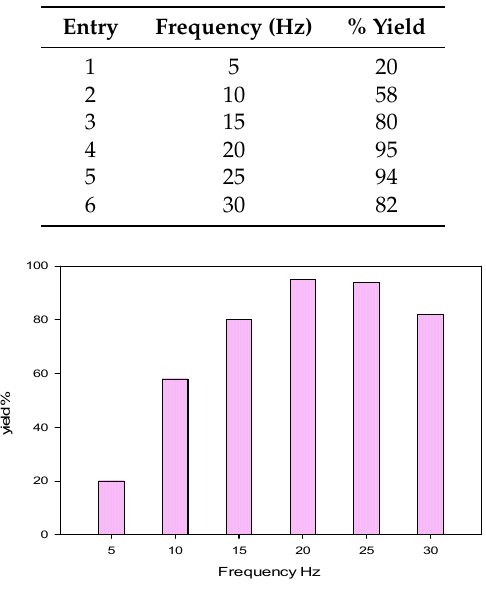
Figure 1. Milling of 2.5 g of o -phenylenediamine and 3 g of benzoic acid with 56.6 g of balls for 60 min.